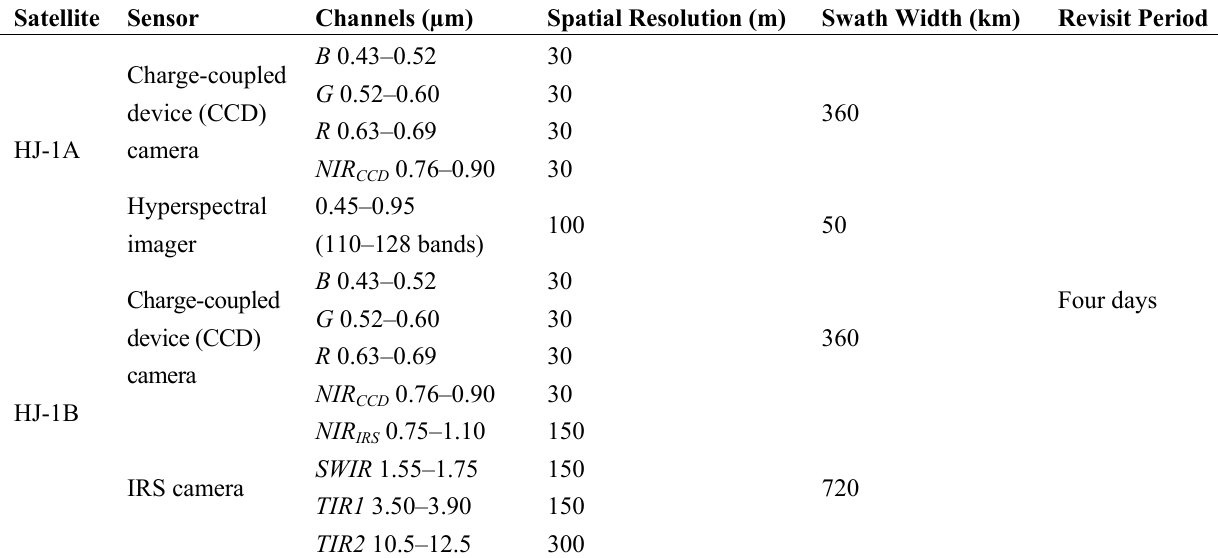
Table 2. Characteristics of HJ-1B onboard